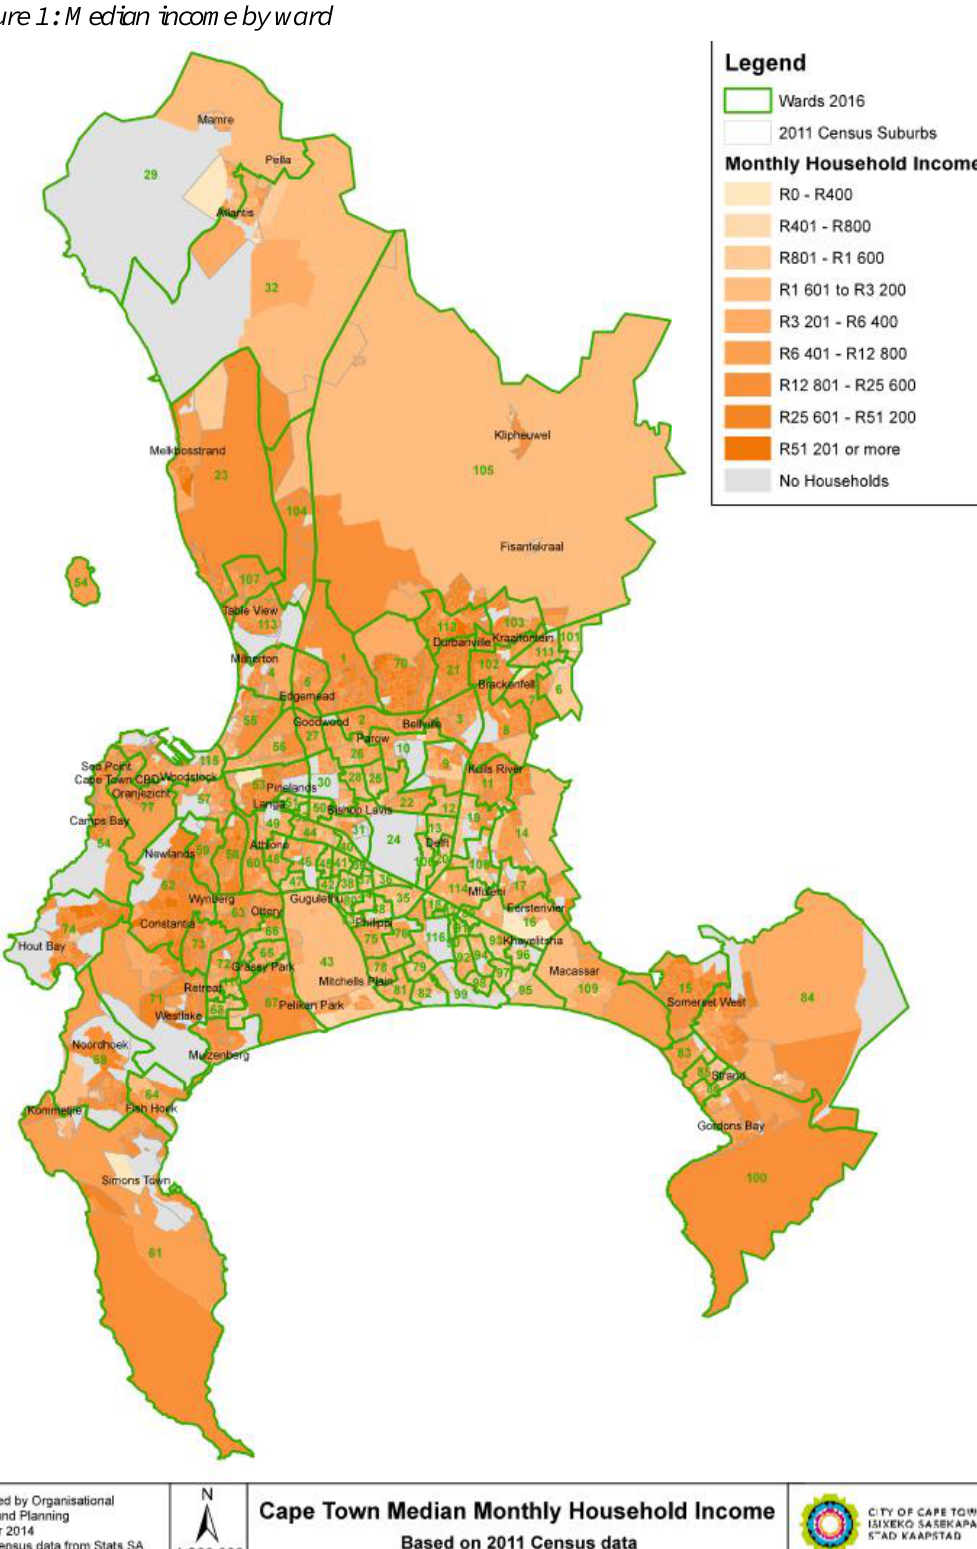
Figure 1: Median income by